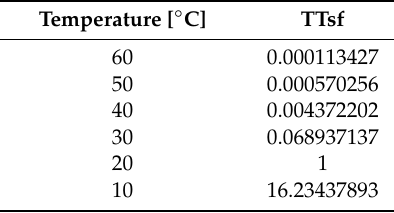
Table 9. TTsf for MORTAR-CR master curve at 20 °C.